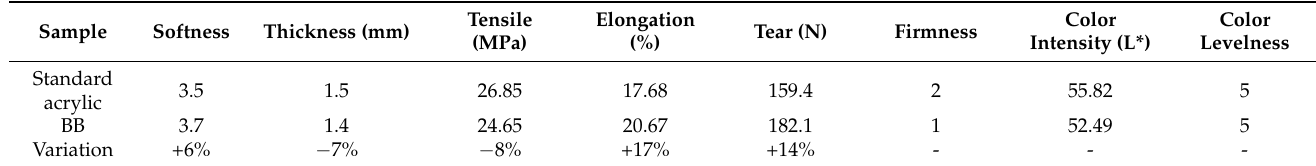
Table 7. Degrees of softness, thickness, firmness, physical resistance, color intensity and color levelness in crust